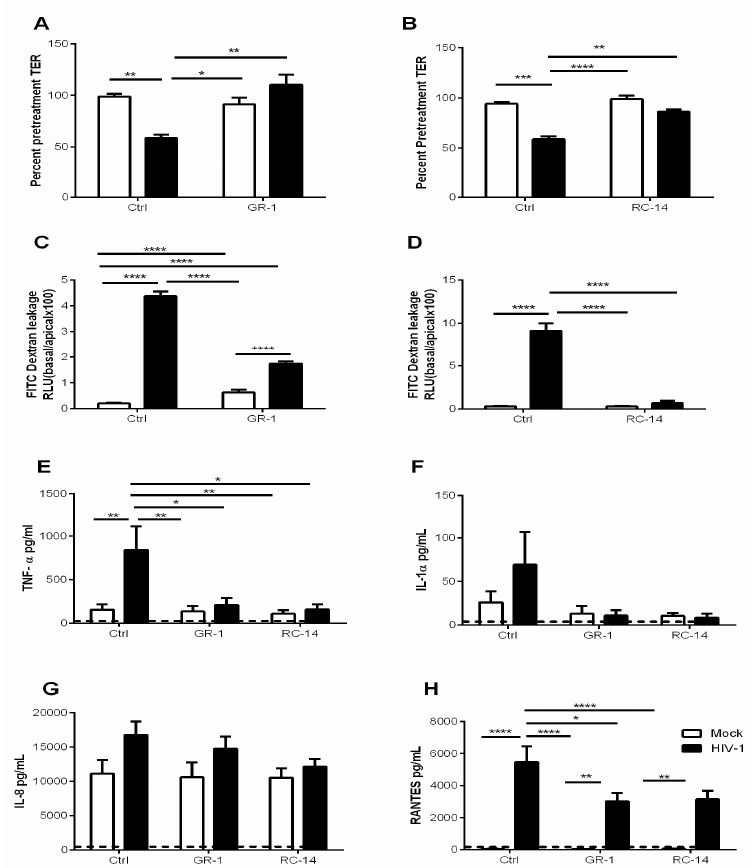
Figure 3. Probiotic strains of lactobacilli ameliorate HIV-1-mediated barrier disruption and downregulate proinflammatory cytokine production by GECs. GECs were treated for 2 h with probiotic strains L. rhamnosus GR-1 and L. reuteri RC-14 abbreviated GR-1 and RC-14 respectively or no bacteria (Control). Following treatment, various cultures of GECs were then exposed to HIV-1 or no virus (Mock) and monitored for 24 h. ( A , B ) TER values were observed pre- and 24 h post-HIV-1 exposure. TER is expressed as percent of TER measured before HIV-1 exposure. ( C , D ) Following treatment with lactobacilli and during viral exposure, GEC cultures were treated apically with FITC-labeled dextran dye. At 24 h, 50 µ L of basolateral were collected and fluorescence was measured using a microplate reader. The dextran leakage in the basolateral compartment is expressed as a percentage of dextran added to the apical compartment. ( E – H ) 24 h post-exposure to HIV-1, cell supernatants were collected and analyzed for TNF- α , IL-1 α , IL-8, and RANTES. Dashed line indicates assay limit of detection. Data shown is representative of 6–9 separate experiments done on cells isolated from 6–9 di ff erent tissues, each experiment had 3 replicate cultures for each experimental condition. Data is plotted as mean + SEM. Statistical significance is indicated: **** p < 0.0001, *** p < 0.001, ** p < 0.01, * p < 0.05.